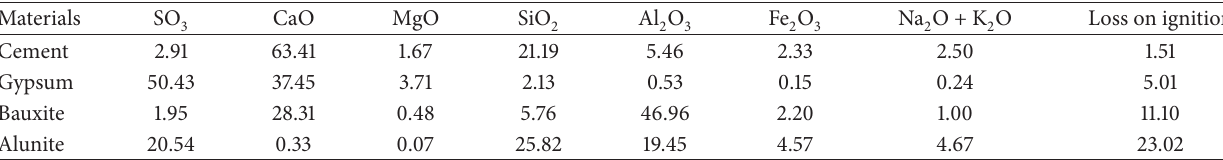
Table 1: Chemical composition of materials (wt%).